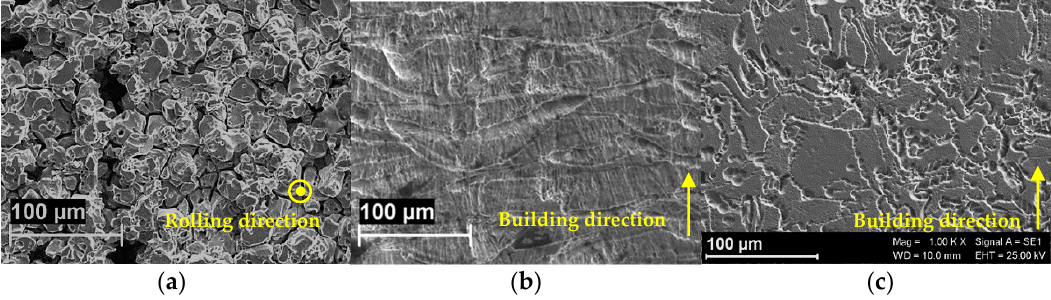
Figure 3. SEM images of the polished surface of the specimens after the tests of intergranular corrosion. ( a ) hot-worked bar, ( b ) LPBF as-built, ( c ) LPBF heat treated.